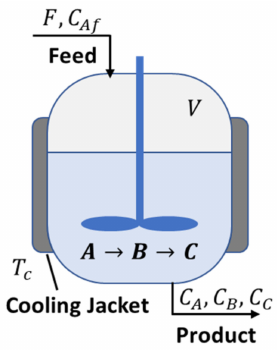
Figure 7. Illustration of a continuously stirred tank reactor (CSTR) with a series reaction [43].